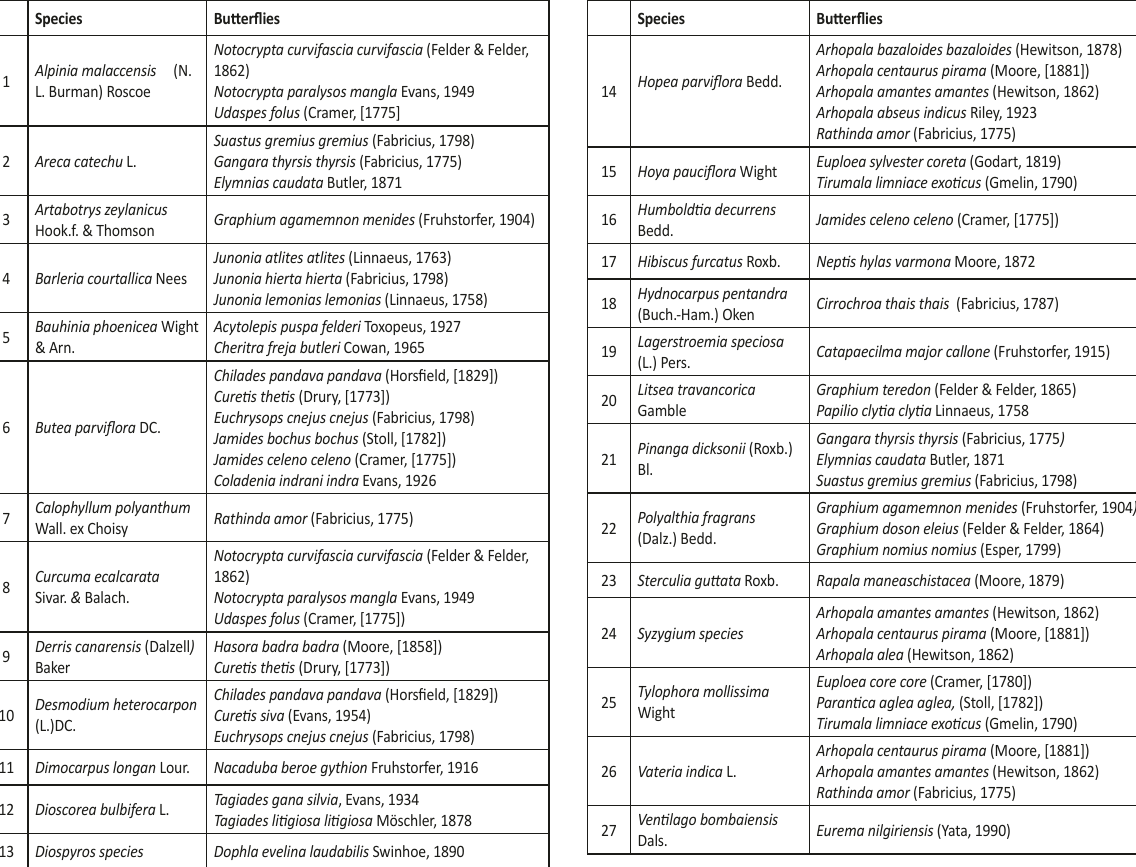
Table 4. Newly discovered larval host-plants for butterflies of Western Ghats, recorded from myristica swamp forests, Shendurney WS, during our study from 2008–2018.